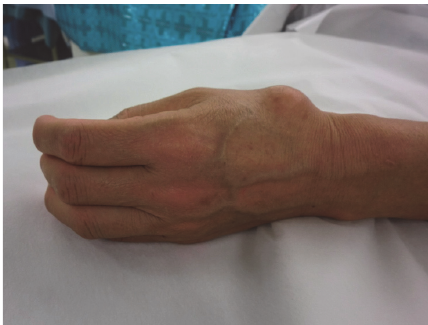
Figure 1: A palpable and tender mass, approximately 2.5 cm ×